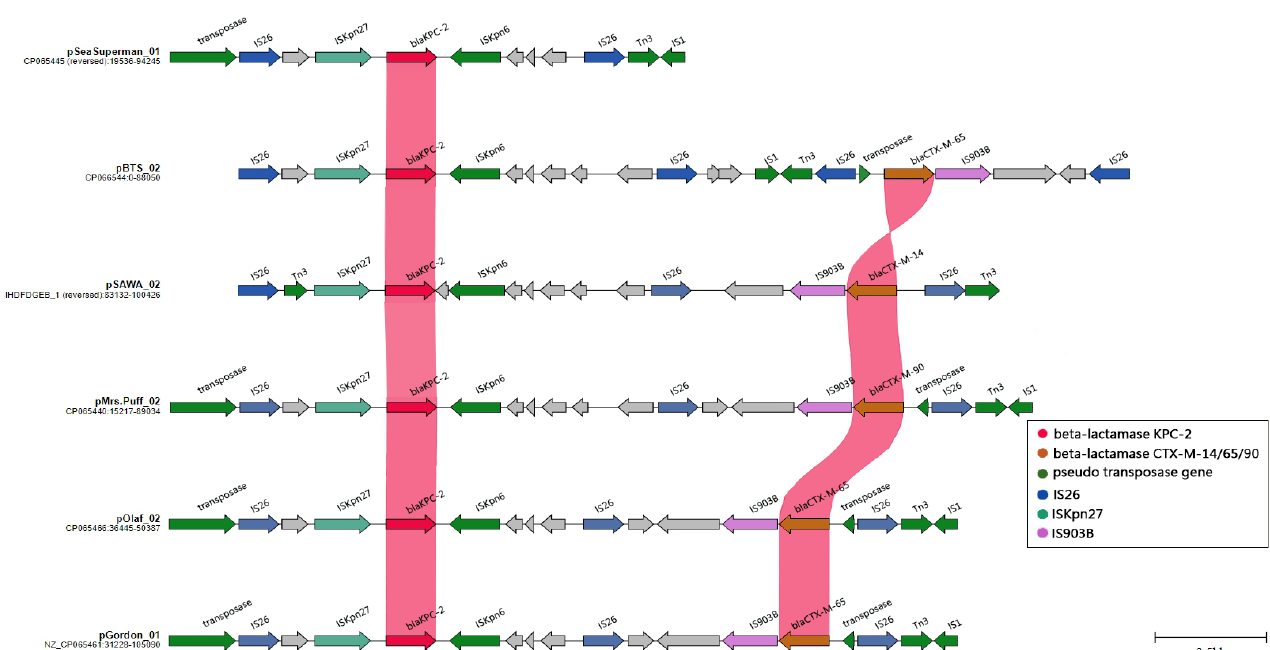
Figure 6. Tracing the evolution of IS26 integrons in plasmid IncFII from CRKP. The figure shows the novel structural organization of IS26- bla KPC-2 - bla CTX-M elements in plasmid IncFII. The progression from the common form 1 (pSeaSuperman_01), to the intermediate form 2 (pBTS_02), and finally to the advanced form 3 (lower 4 plasmids) suggests that IS26 integrons have undergone evolution and expansion, which may have contributed to the development of carbapenem resistance in these K. pneumoniae strains.